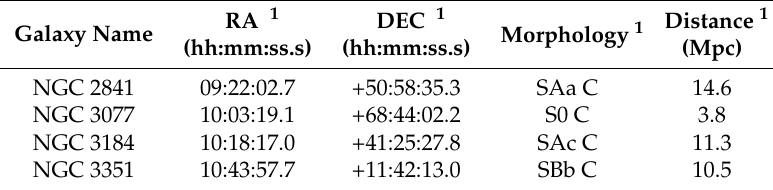
Table 1. Galaxy sample morphology and positions.